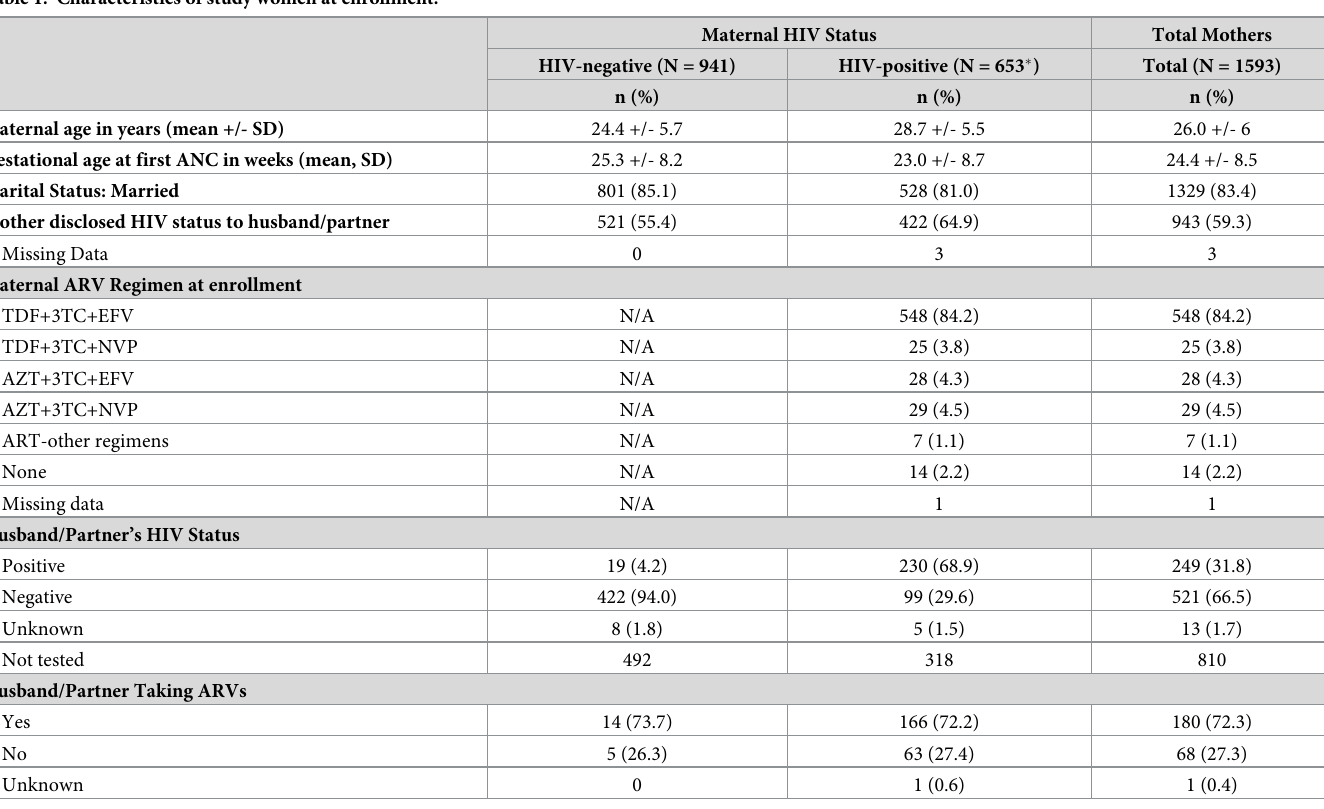
Table 1. Characteristics of study women at